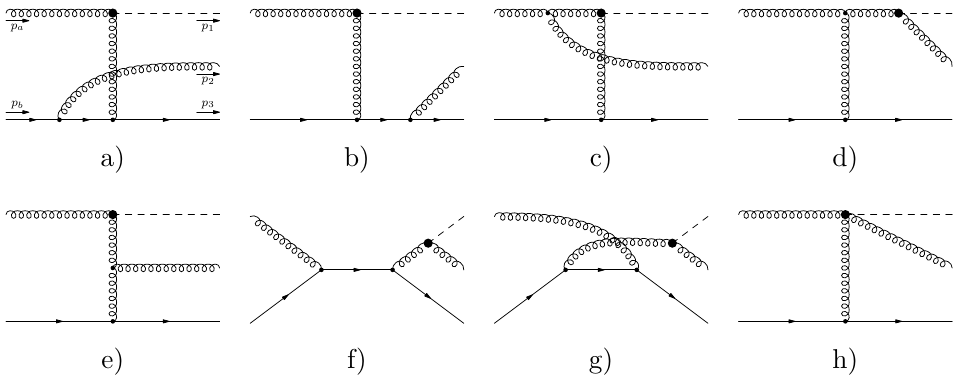
Figure 5. The eight LO diagrams which contribute to the process in equation